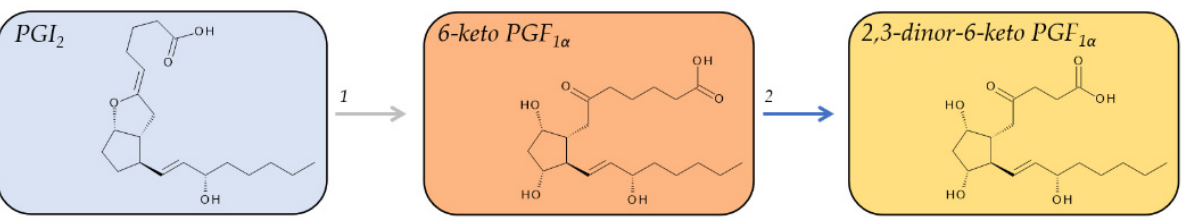
Figure 6. Major metabolic pathway of PGI 2 . Metabolites on a red background are regarded as major plasma metabolites; metabolites on a yellow background are major urinary metabolites The grey arrow indicates non-enzymatic decomposition and the blue arrow oxidation reactions. 1, non-enzymatic degradation; 2, enzymatic β‐ oxidation.